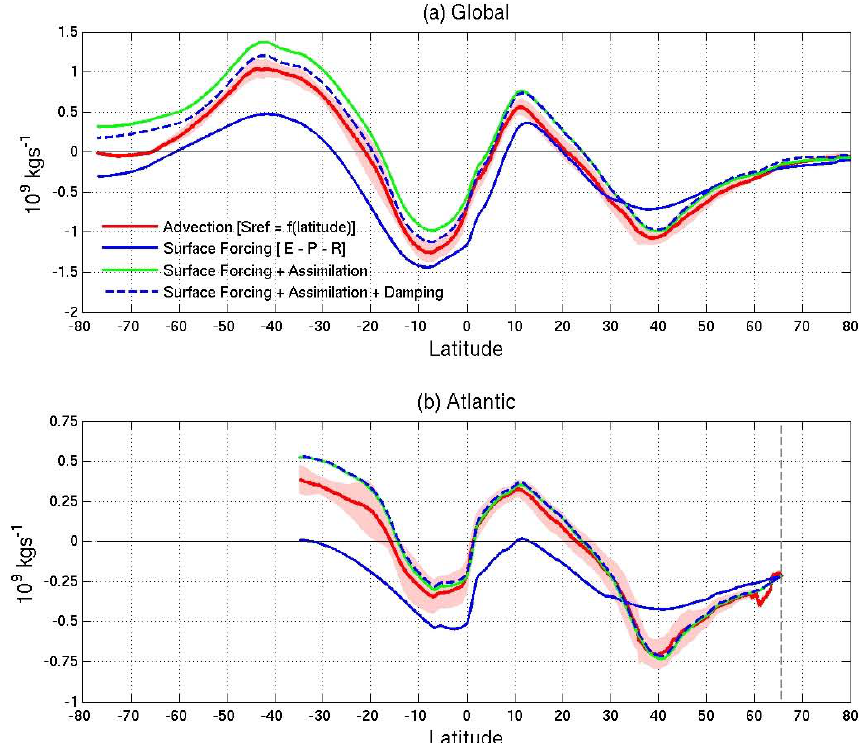
Fig. 8. Meridional freshwater transports from UR025.3 over 1993–2009 for (a) the global ocean and (b) the Atlantic Basin. The Advection (red) is based on the resolved velocity and salinity fields, including all eddy components down to the 5 day time scale. The shaded area shows the annual standard deviations in advective transport. The solid blue line uses surface freshwater fluxes and a steady state assumption to calculate meridional freshwater transport, and the dashed blue line uses surface freshwater fluxes combined with assimilation increments to do the